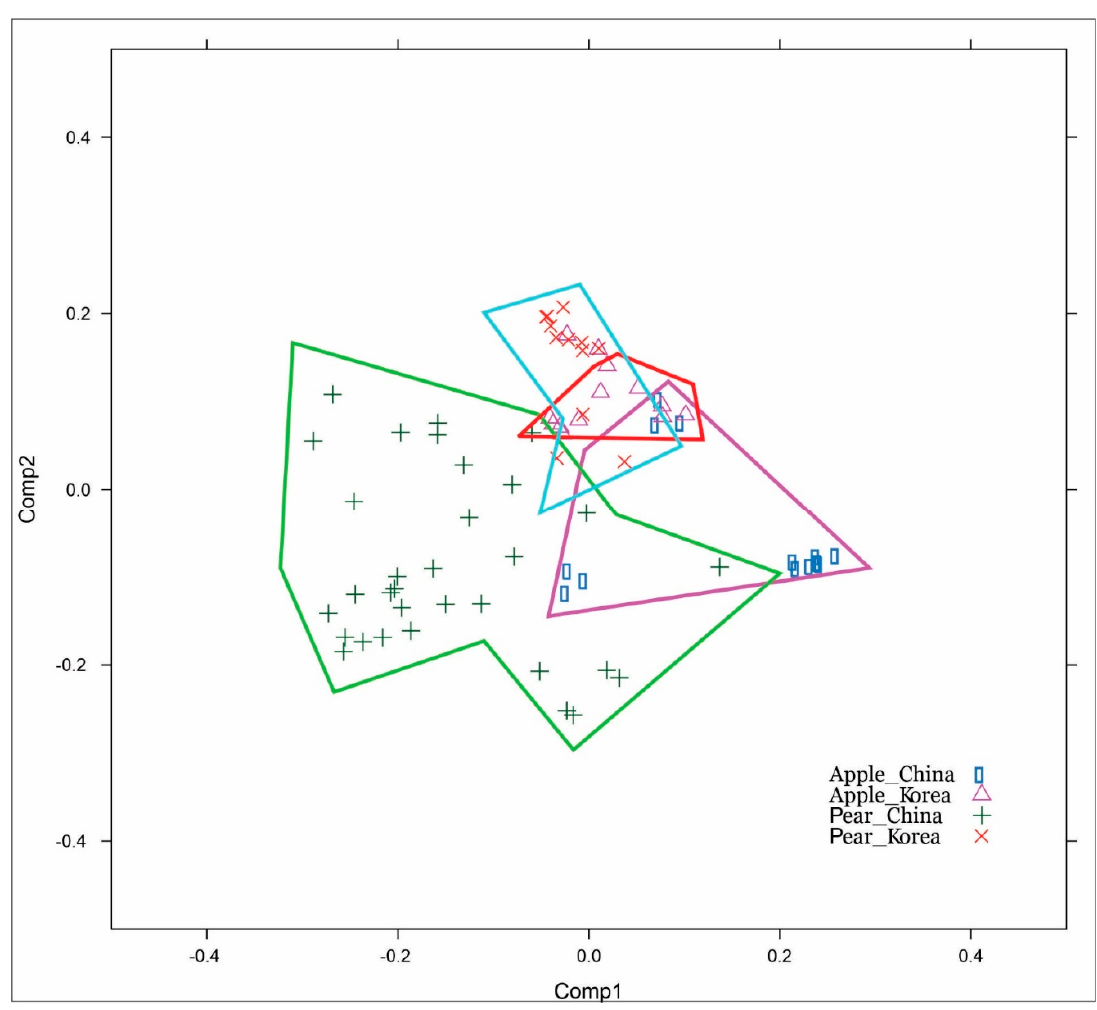
Figure 8. Correspondence analysis with codon usage of apple stem grooving virus (ASGV) coat protein gene from Korea and China. Codon usage of ASGV corresponded with the host and country of collection. Region with red boundary line indicates in majority the Korean ASGV collected from apple. The area with a blue boundary shows Korean ASGV collected from pear. Region with a pink boundary indicates Chinese ASGV collected from apple. Region with green circumference indicates Chinese ASGV collected from pear.